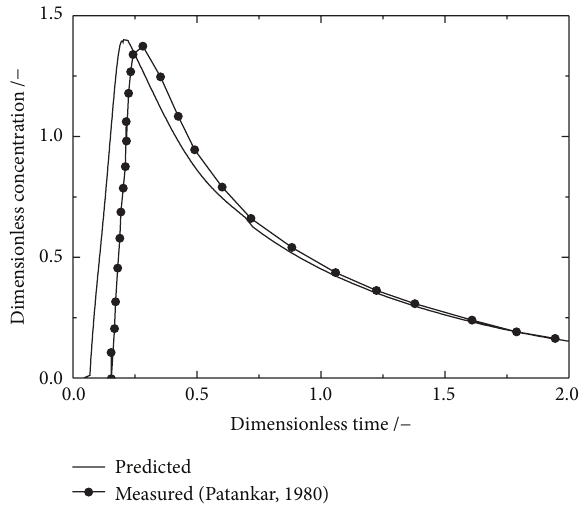
Figure 4: Comparison of the predicted and measured RTD